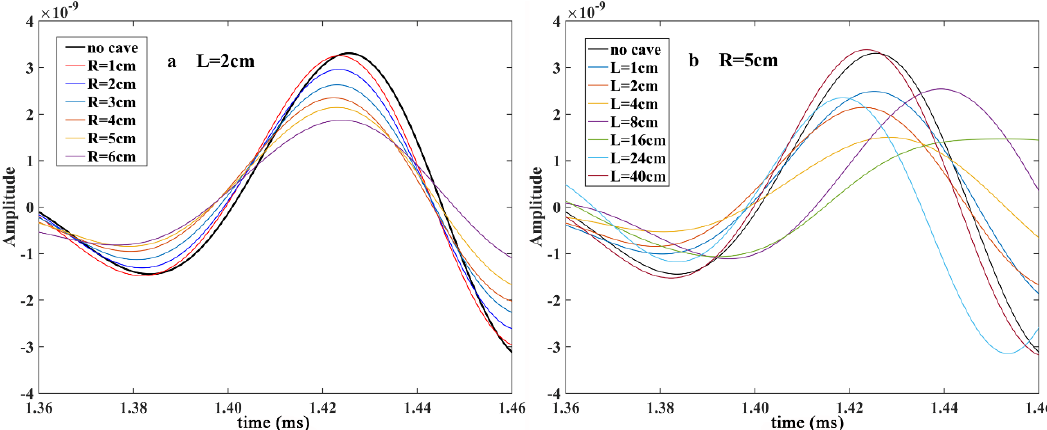
Figure 8. Effect of the radius and position of cave on S-wave. ( a) shows the effect of the cave radius on S-wave. ( b) shows the effect of the cave position on S-wave. R represents the radius of the cave and L represents the distance of the cave to the borehole wall. Center frequency of source is 10 kHz. S-wave recorded by the receiver 0.4 m above the cave.